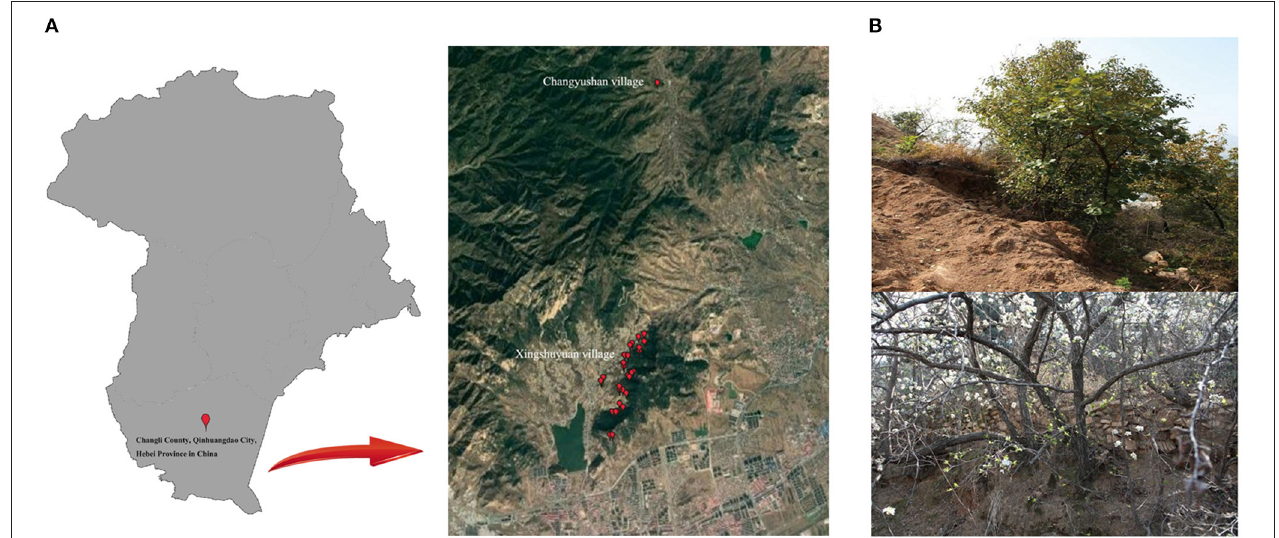
FIGURE 2 | (A) Distribution of part of the P y rus hopeiensis ; (B) Habitat of Pyrus hopeiensis .